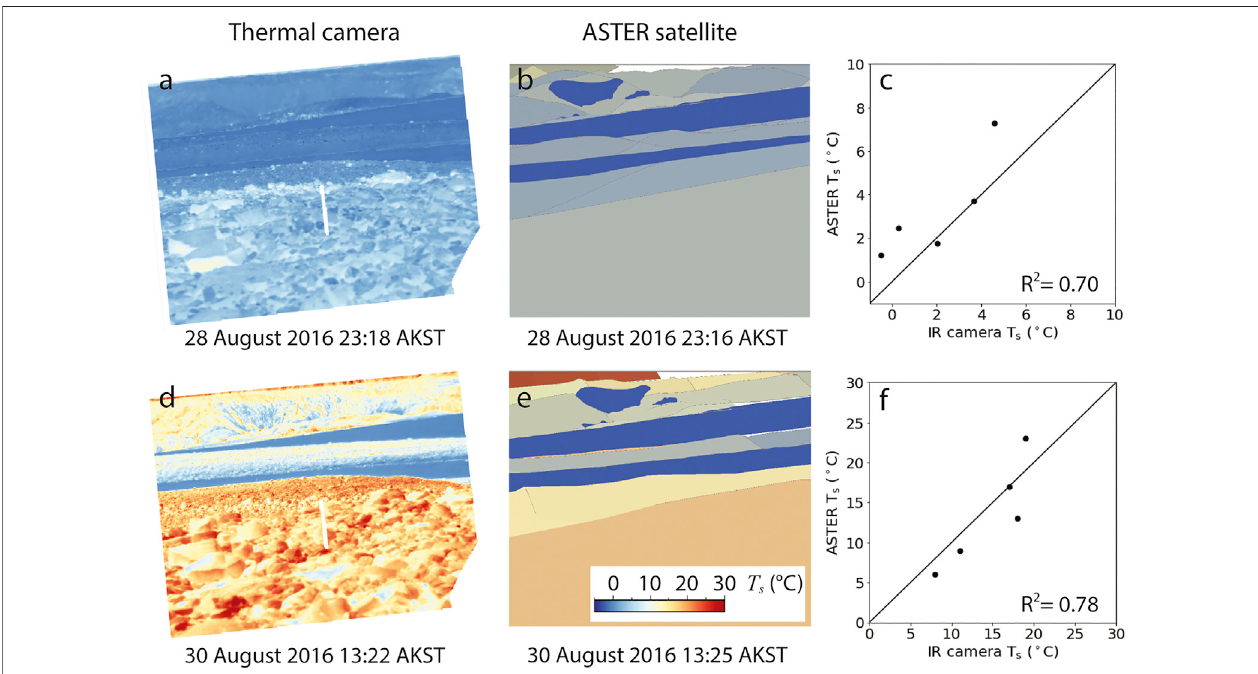
FIGURE 8 | Two image pairs of oblique fi eld-based thermal camera data coupled with space-borne ASTER thermal data that are coincident in time. The ASTER data isdraped over aDEM and displayed obliquely to match the view angleof the thermal camera image. The image pair (A,B) are coincident in timeby 2 min and (D,E) are coincident in time by 3 min. Surface temperatures were averaged over the image segments shown in Figure 1A,B ; regression is shown between the infrared (here shortened to “ IR ” ) camera and ASTER thermal data. Bare ice segments were excluded from the regression because the ASTER values were unnaturally set to 0 ° C from Eq.15 .The1:1lineisplottedforreference. (C) correspondstoimagepair (A,B) ; (F) correspondstoimagepair (D,E) .Temperaturesin (A,B,D,E) areallscaledtothe temperature scale in (E) .